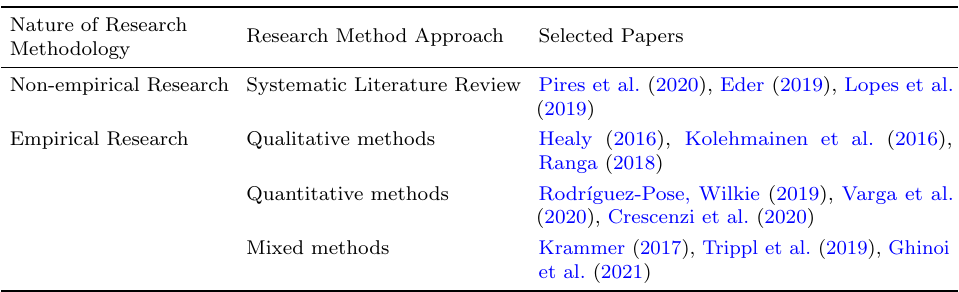
Table 4: The diversity in research design and methodology Nature of Research